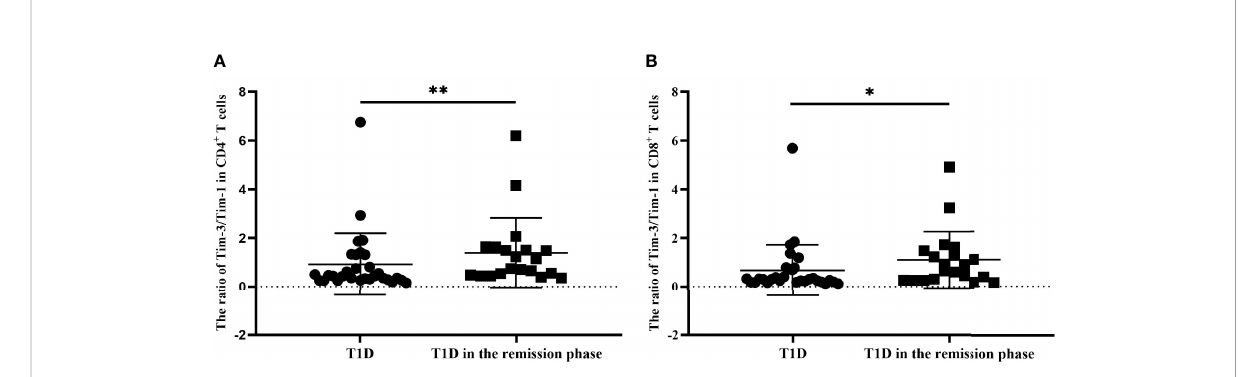
FIGURE 6 The ratio of Tim-3 to Tim-1 in different T-cell subsets form T1D and T1D in the remission phase. (A) The ratio of Tim-3 to Tim-1 in CD4 + T cells from T1D and T1D in the remission phase. (B) The ratio of Tim-3 to Tim-1 in CD8 + T cells from T1D and T1D in the remission phase. * P <0.05.; ** P